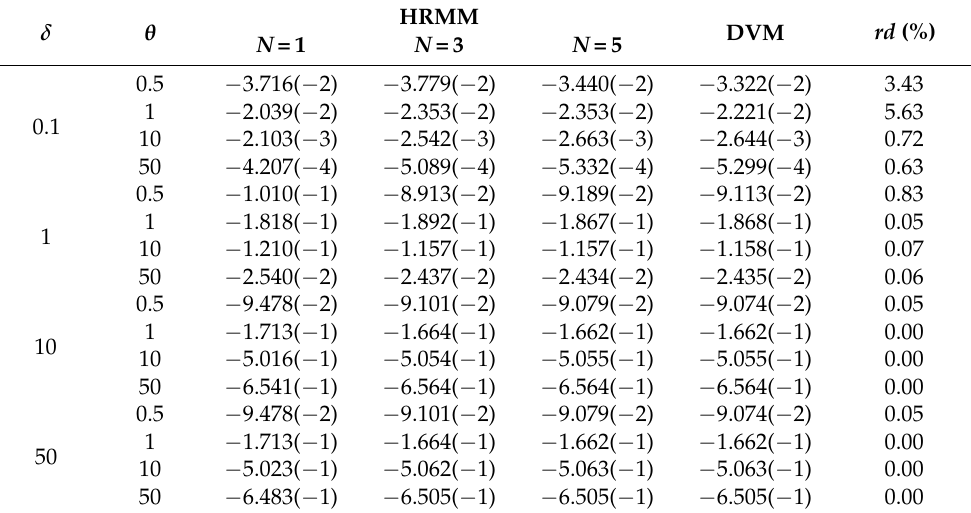
Table 5. Oscillatory Couette flow; shear stress phase (rad) at the oscillating wall p xy,P ( y = 0) for various values of δ and θ based on the HRMM, with N = 1,3,5 and the DVM, along with the relative difference between corresponding